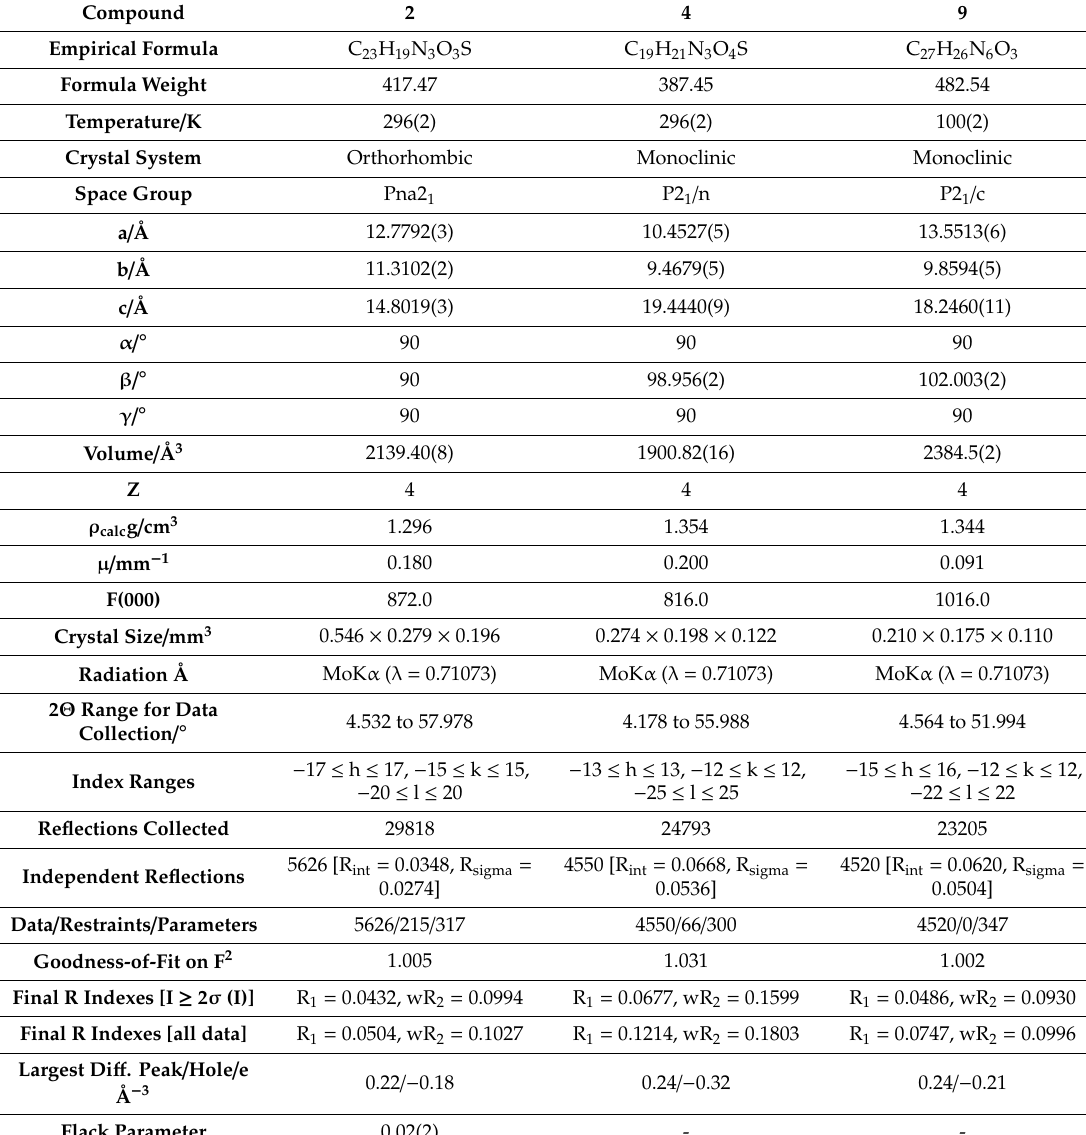
Table 3. Crystal data parameters for compounds 2 , 4 , and 9